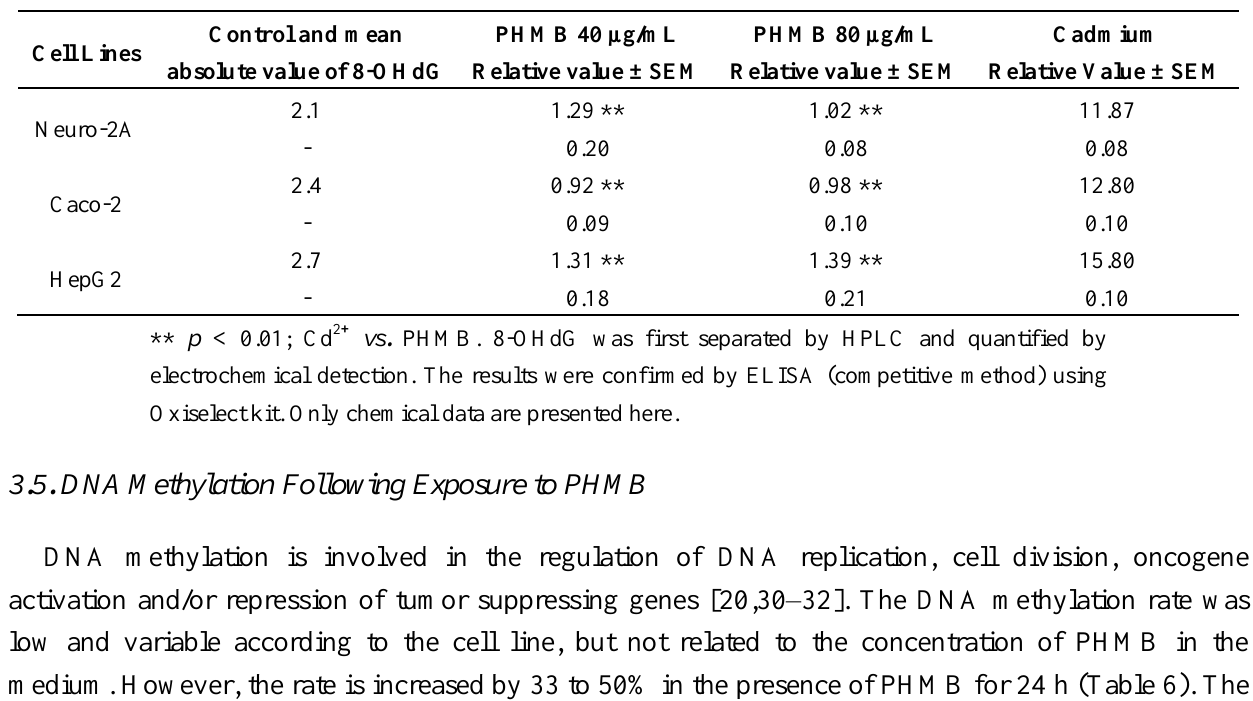
Table 5. Effect of PHMB on DNA base oxidation in Neuro-2A, Caco-2 and HepG2 cell lines. Cells were incubated with PHMB or cadmium (Cd 2 +) (positive control) for 3 h or 24 h. Results are expressed as ng of 8-OHdG/mL in 10 µg of DNA. Relative values were calculated as oxidized bases in the DNA of treated cells/oxidized bases in the DNA of untreated